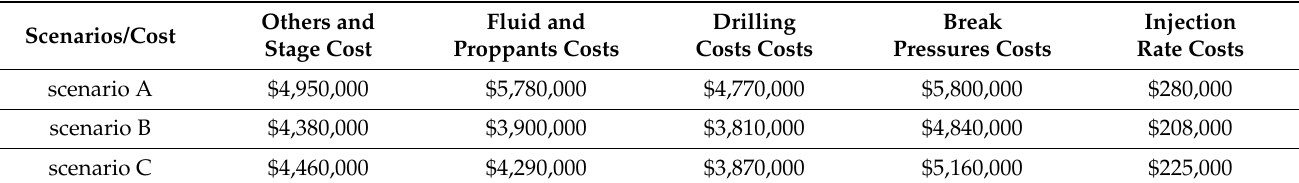
Table 4. After defuzzified results of long-term cost estimation of hydraulic